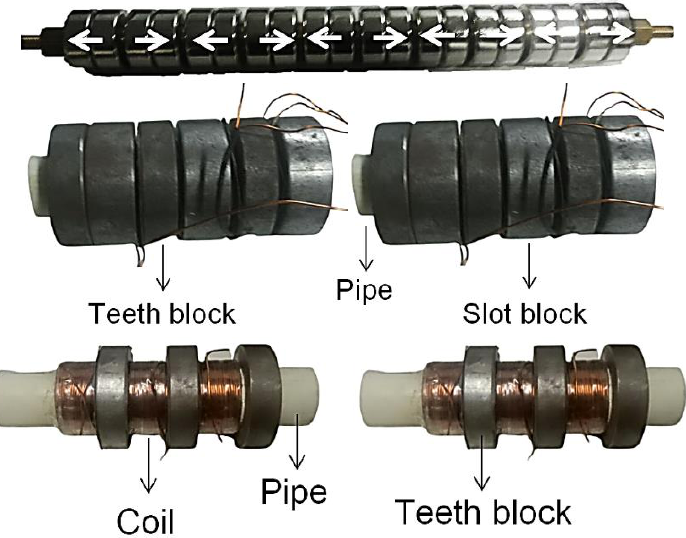
Figure 6. Components of the small-scale LPMG: translator with permanent magnets completed with the magnetic orientations ( top ), iron-cored’s stator ( middle ), semi iron-cored’s stator ( bottom ).